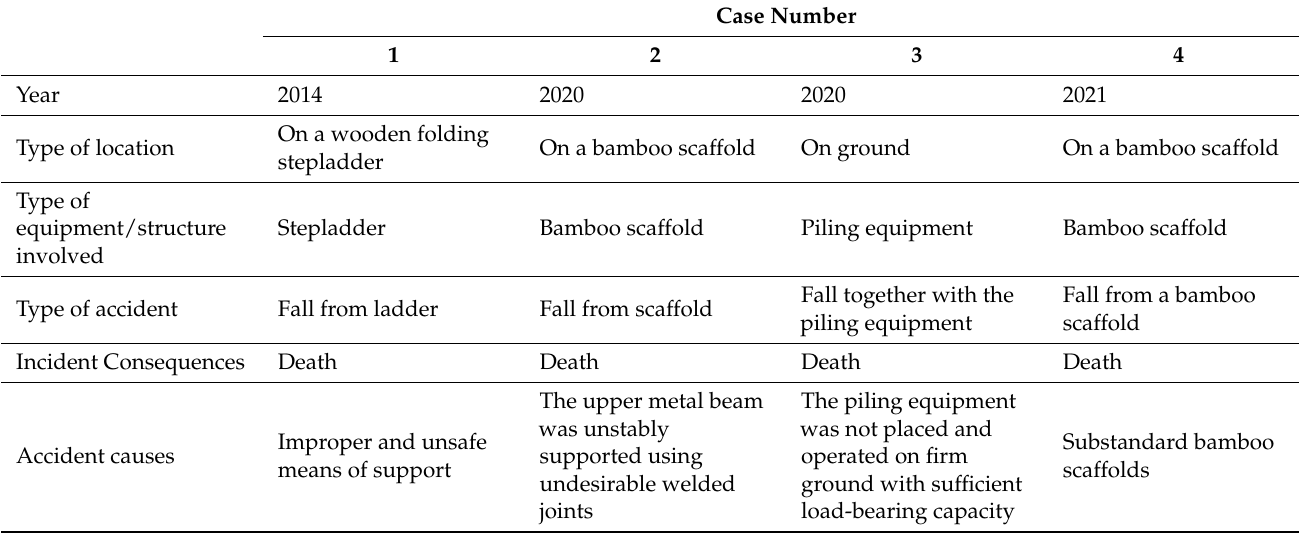
Table 1. Fall fatality cases in Kai Tak Development